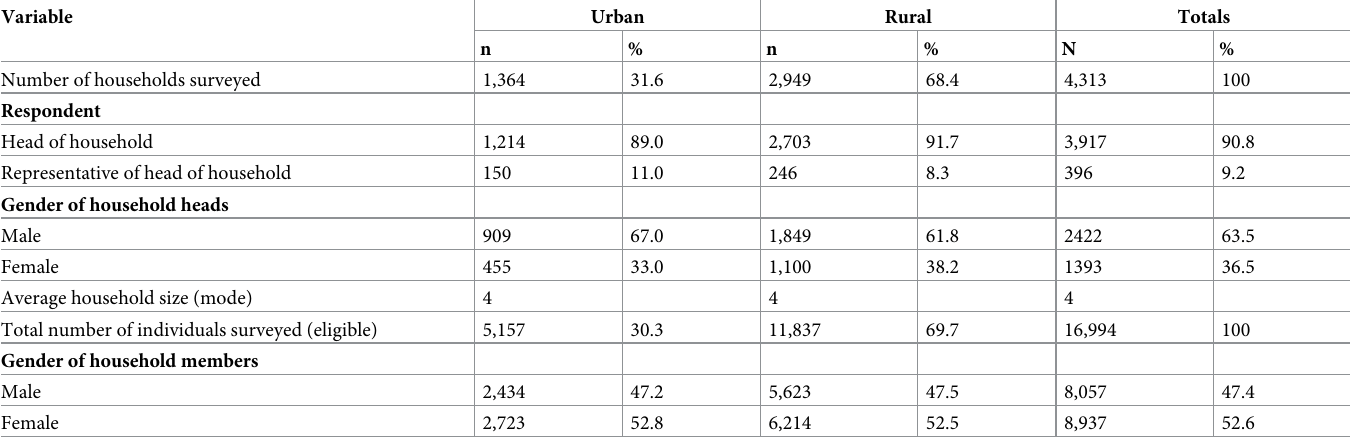
Table 1. Demographic and household composition (unweighted), AKAIS